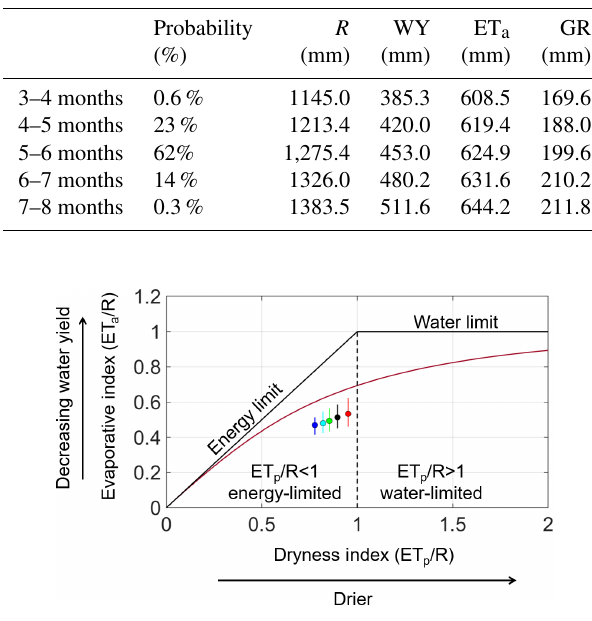
Figure 12. Budyko diagram relating the dryness index (ET p /R ) with the evaporative (ET a /R ) index classified according to the dura- tion of the rainy period pertaining to the dynamic approach. Circles denote the median and vertical colored lines represent the range be- tween the 5th and 95th percentiles of the evaporative index (red, black, green, cyan, and blue correspond to the duration of the rainy period of 3–4, 4–5, 5–6, 6–7 and 7–8 months, respectively). Solid lines denote energy and water limits; the solid garnet line represents the Budyko curve (Budyko, 1974). The vertical dashed line sepa- rates the left-hand side from right-hand side of the Budyko curve.